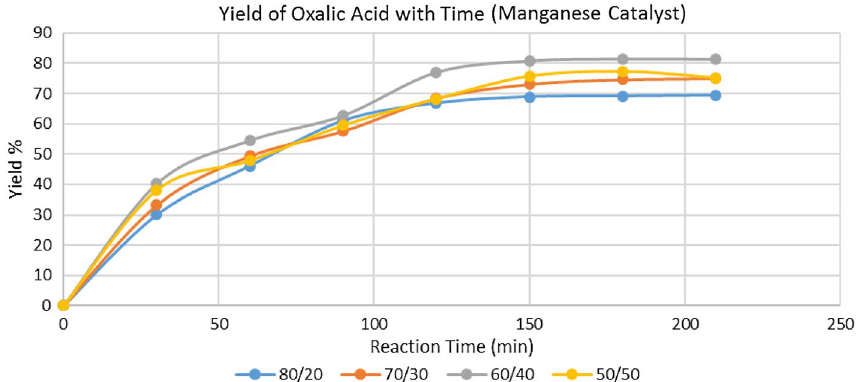
Fig. 6 Yield of oxalic acid with time using different acid ratios and manganese